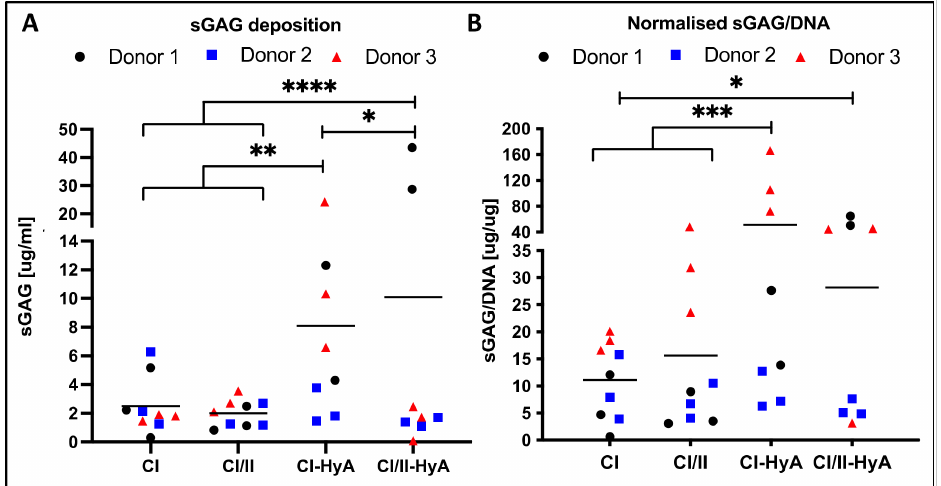
Figure 3. All scaffolds supported effective sGAG deposition by the human MSCs, with improved cartilage-like matrix deposition for the composite CI-HyA and CI/II-HyA scaffolds. Overall sGAG per scaffold ( A ) and sGAG normalised to DNA content ( B ), respectively, were determined after 28 days in culture. Data shown represent the grand mean from three individual human MSC donors n = 3 (unless indicated differently). * denotes p ≤ 0.05, ** = p ≤ 0.01, *** = p ≤ 0.001 and **** = p ≤